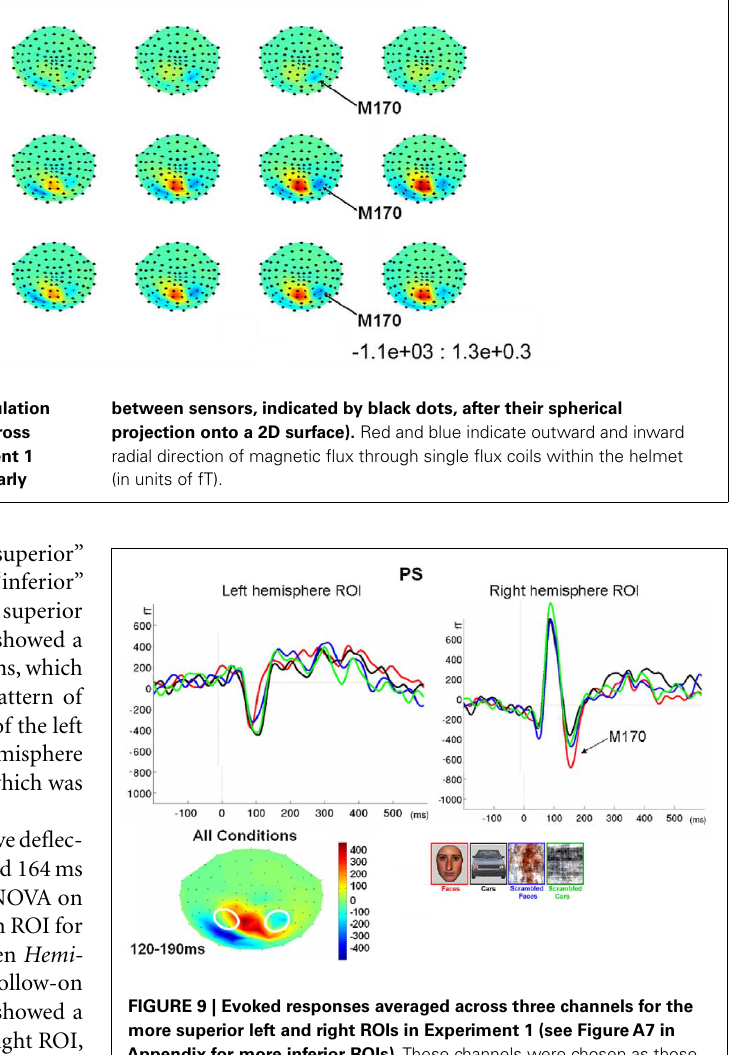
FIGURE 9 | Evoked responses averaged across three channels for the more superior left and right ROIs in Experiment 1 (see FigureA7 in Appendix for more inferior ROIs). These channels were chosen as those with the maximal negative deflection vs. baseline in the right hemisphere from 120 to 190ms, averaged across conditions, highlighted in white on topography below (these are Neuromag channels “MEG2441,” “MEG2311,” and “MEG2231” for the right ROI, and “MEG1841,” “MEG1631,” and “MEG1911” for the left